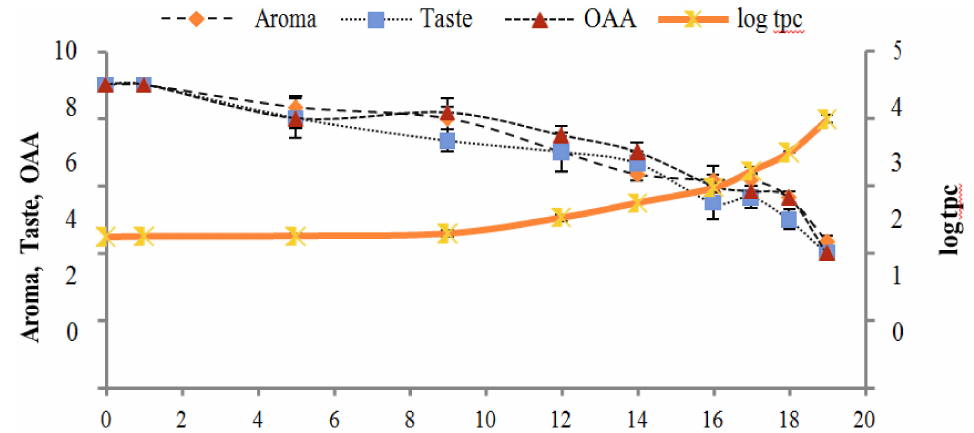
Figure 10. Relationship of total psychrotrophs count log cfu/mL growth trends with sensory scores of pasteurized milk for spoilage detection stored at 10 ◦